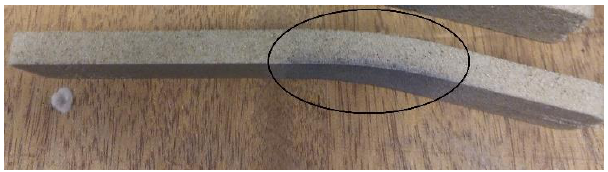
Figure 20. Deformed sample after hot distortion.